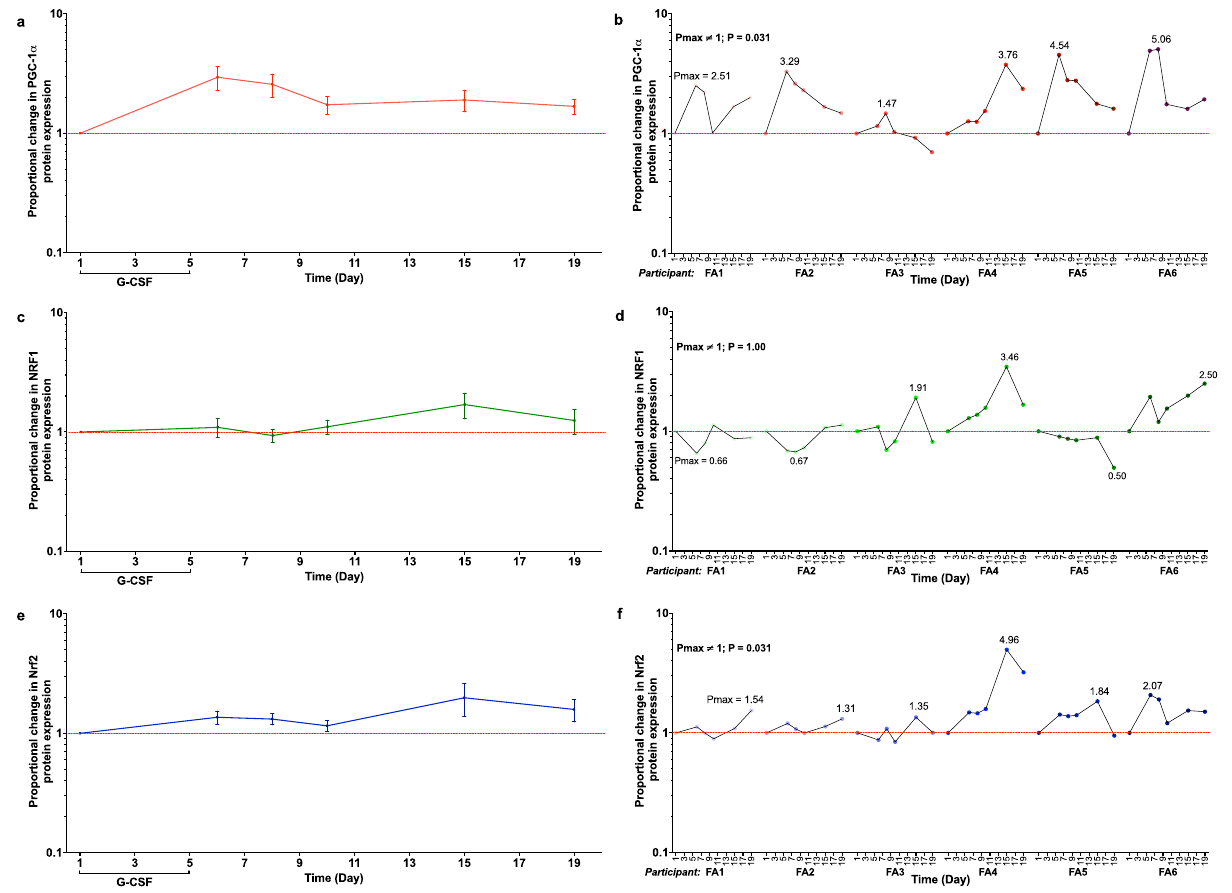
Fig. 5 Antioxidant defences are elevated in PB MNCs in response to G-CSF administration. The proportional changes in ( a ) PGC-1 α , ( c ) NRF1 and ( e ) Nrf2 protein expression in PB MNCs, relative to baseline (day 1) levels, over the 19-day study period (graph depicts mean ± standard error; n = 6 biologically independent samples); data from individual participants are shown in graphs ( b ; PGC-1 α ), ( d ; NRF1) and ( f ; Nrf2). The sign test (two-sided) was used to compare P max values to a theoretical median of 1.0. Source data are provided as a Source Data fi